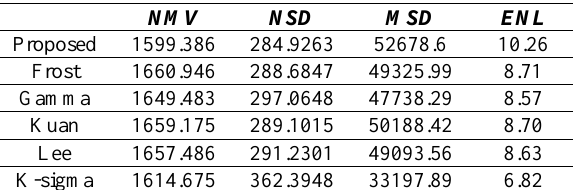
Table. 2: Speckle noise reduction results of RADARSAT